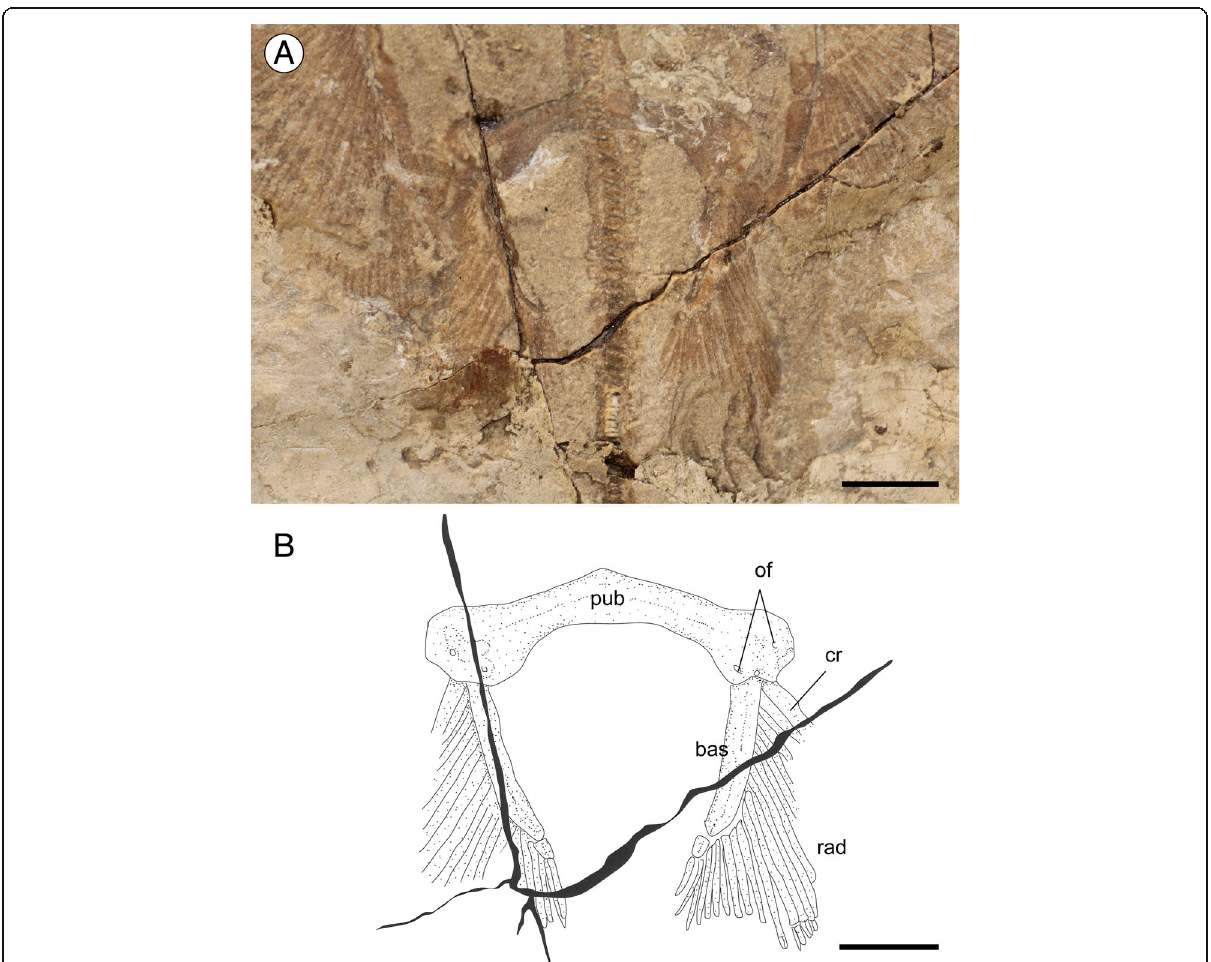
Fig. 5 Promyliobatis gazolai from the Eocene of the Bolca Lagerstätte. a Detail of the pelvic region of the holotype MCSNV VII.B.90/91. b Reconstruction. Abbreviations: bas; basipterygium; cr, compound radial; of, obturator foramina; pub, puboischiadic bar; rad, pelvic radials. Scale bars = 10